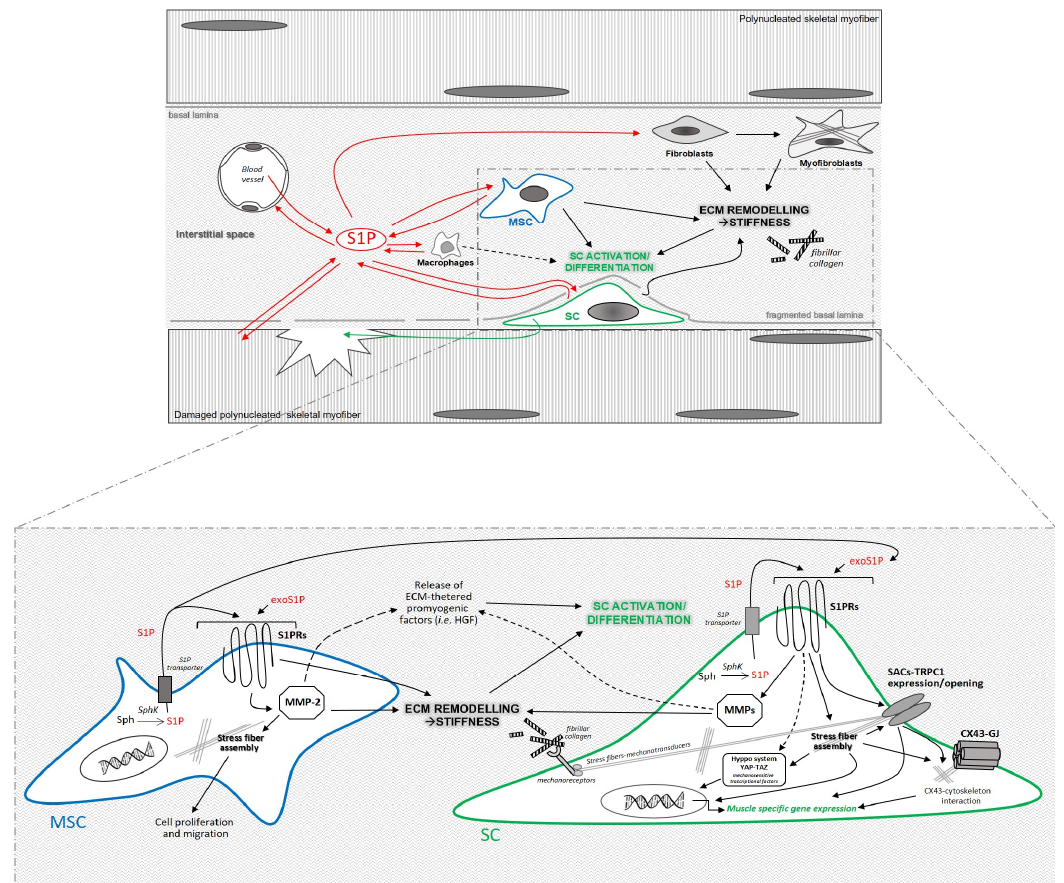
Figure 1. Drawing representing the potential influence of S1P released in the context of damaged skeletal muscle tissue by blood and different cells, via S1PRs in the regulation of mechanobiology of satellite cell (SC) niche, namely, SC mechanotransduction events in response to ECM stiffness and the modulation of ECM stiffness. The interplay between MSCs and SCs in such context has been highlighted. Abbreviations not present in the text: exogenous S1P (i.e., not synthetized and released by the target cell), exoS1P; gap junctions, GJ. Dotted lines: unknown pathways.